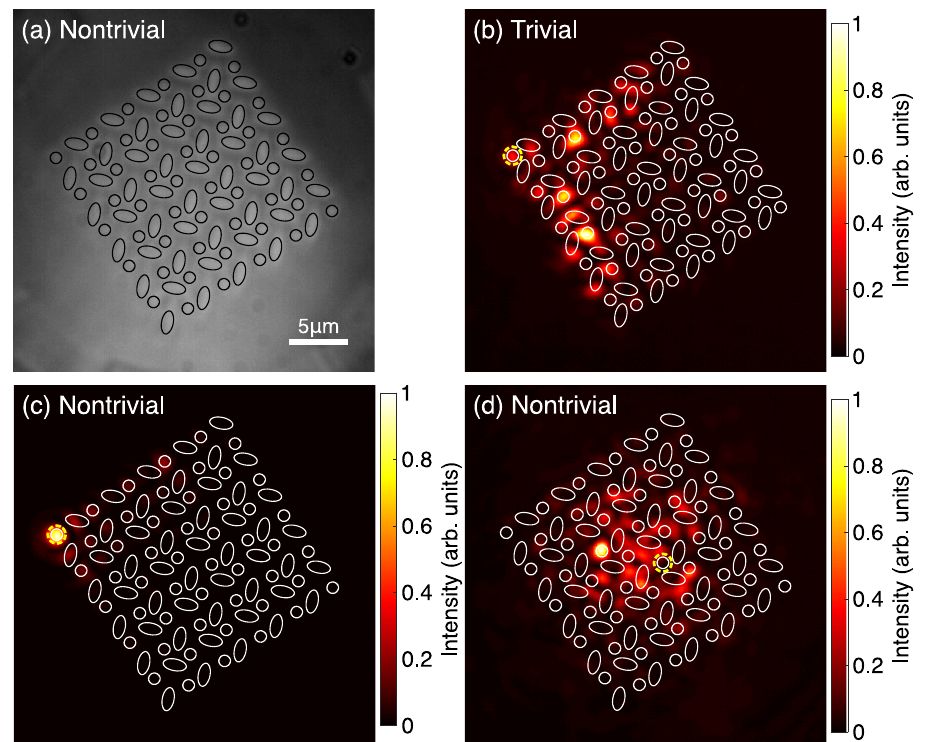
Fig. 3 | Experimentally measured diffracted light at the output facet. a Cross- sectional image of the output facet of the waveguide array in the nontrivial phase with a broad illumination of the input facet (see Supplementary Fig. S3). b – d Measured intensity pro fi les at the output facet of the waveguide structures. Waveguides, where light is injected at the input facet, are indicated with yellow dashed circles. The intensity pro fi les are normalized to their respective maximum